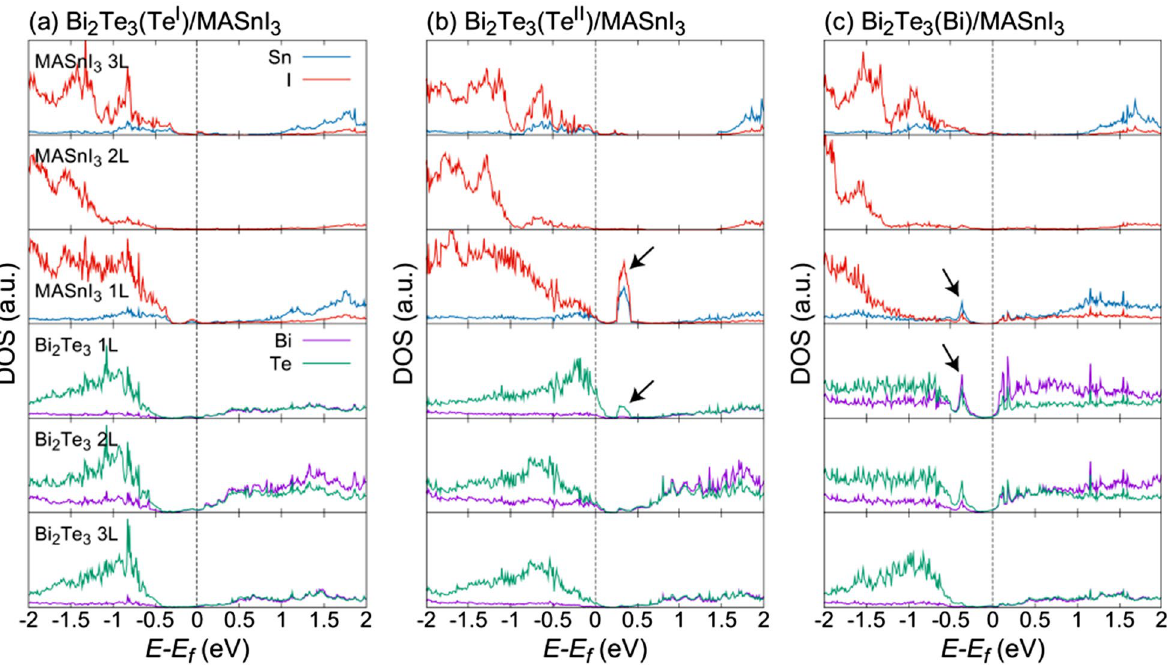
Figure 4. Decomposed DOS of each layer near interface for ( a ) Bi 2 Te 3 (Te I )/MASnI 3 ; ( b ) Bi 2 Te 3 (Te II )/MASnI 3 ; and ( c ) Bi 2 Te 3 (Bi)/MASnI 3 . The DOS of Bi, Te, Sn, and I consist of the sum of the s- and p-orbitals. The atoms included in each layer are shown in Fig. 5. The arrows indicate interface levels formed from Bi 2 Te 3 and MASnI 3